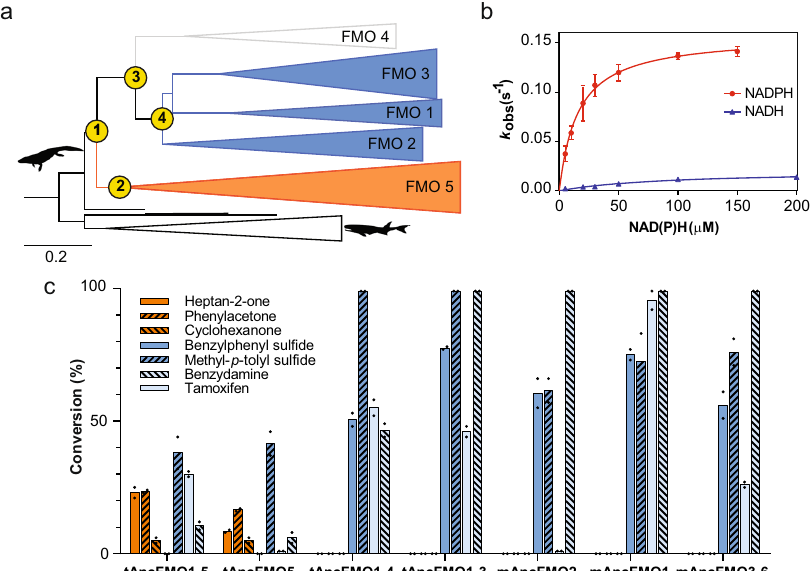
Fig. 2 | Ancestral sequence reconstruction and activity pro fi le of tetrapods ’ FMOs. a Collapsed phylogeny of FMOs from jawed vertebrates with the targeted ancestors at the nodes: (1) tAncFMO1 – 5, (2) tAncFMO5, (3) tAncFMO1 – 4, and (4) tAncFMO1 – 3 (yellow circles). Clades are colored based on the activity of the mammalianancestor:S/Noxidation(blue),BVoxidation(orange).Noexperimental con fi rmation forFMO4activity is available. The depicted silhouettes representthe ancestral tetrapod (by Dmitry Bogdanov (vectorized by T. Michael Keesey) under CC BY-SA 3.0) and actinopterygii (ray- fi nned fi sh). The scale bar represents the substitutions per site. b Steady-state kinetics for tAncFMO1 – 4 toward NADPH (red line, K M =15.7±1.8 μ M) and NADH (blue line, K M =90±17.6 μ M). Methyl- p -tolyl